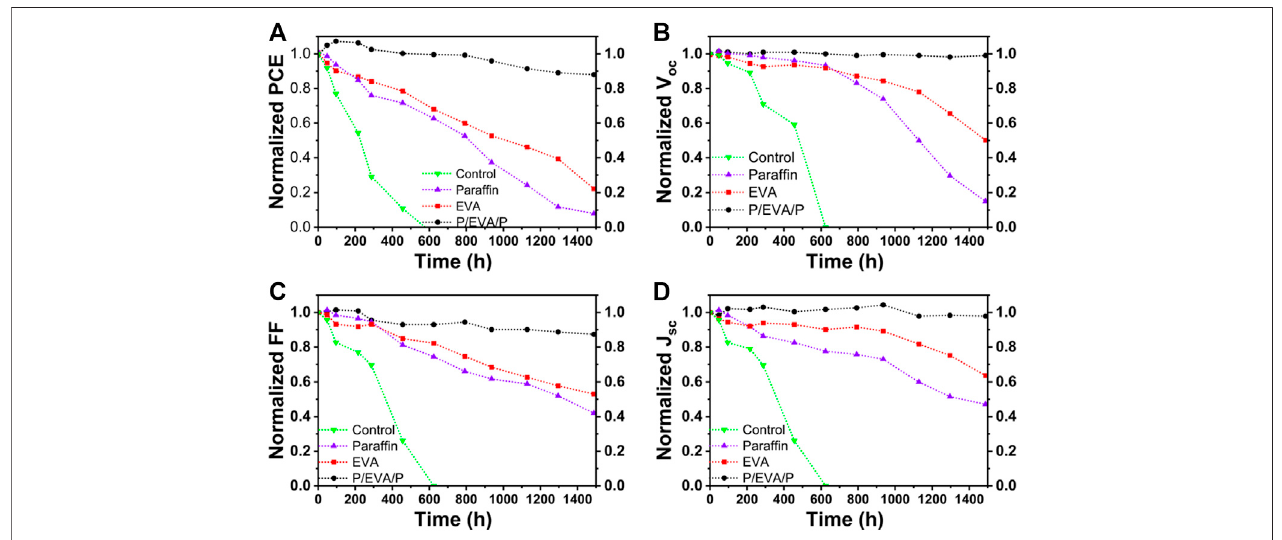
(B) ,FF (C), and J (D) agedfor RH OC SC